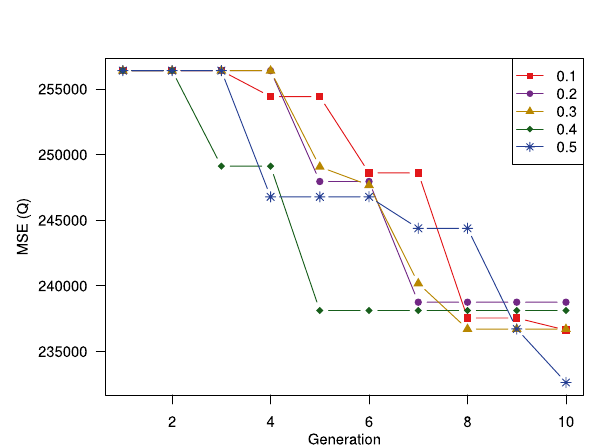
Figure 11. Impacts of percentage of heuristic mutation on model performance. Using the heuristic mutation with the ratio of 0.4% outperforms the others.